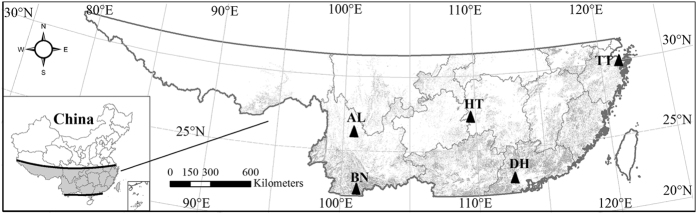
Locations of the five field stations in China’s tropical and subtropical evergreen broadleaved forests(Map created using ARCGIS 10.1 software by first author, URL: http://www.esri.com).The five field stations are TT-Tiantongshan, DH-Dinghushan, HT-Huitong, BN-Xishuangbanna, and AL-Ailaoshan.